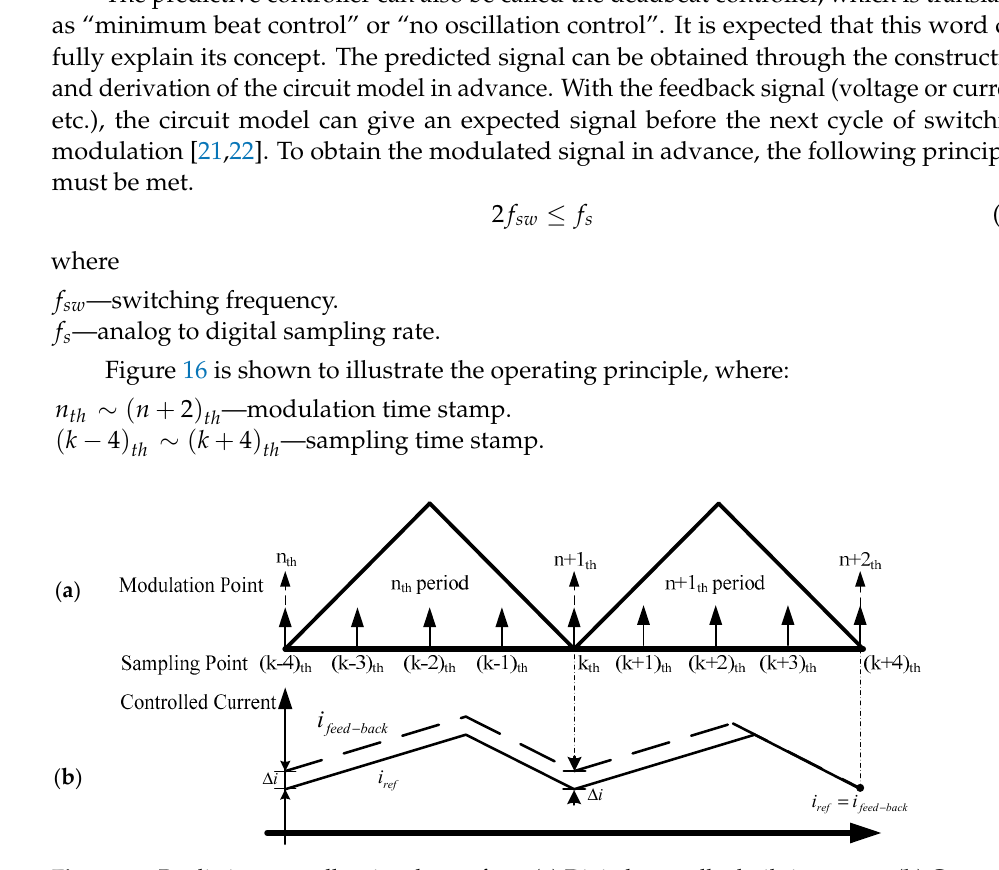
Figure 16. Predictive controller signal waveform ( a ) Digital controller built-in counter ( b ) Command current and feedback current.